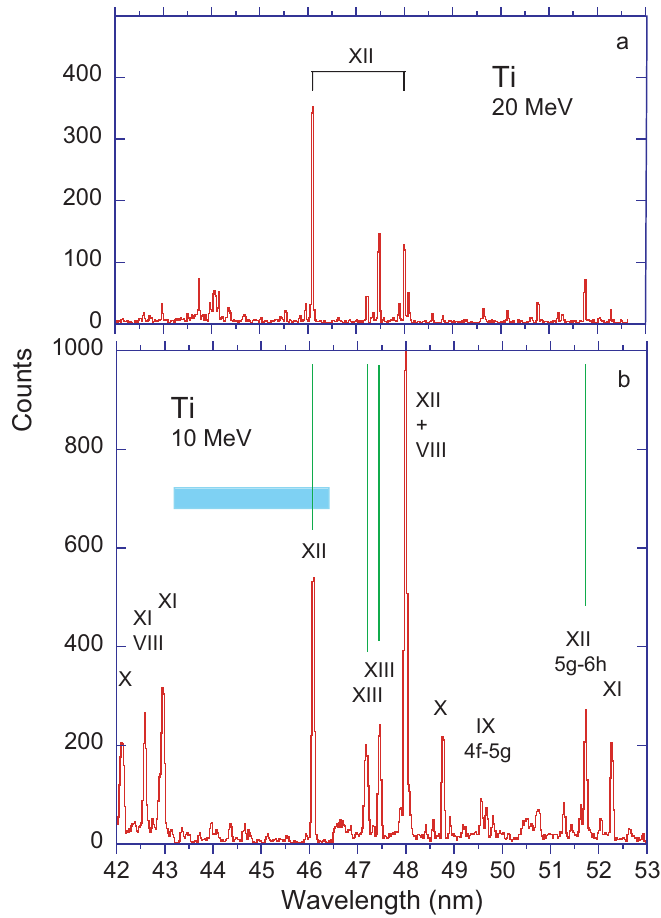
Figure 7. Continuation of the Ti spectra shown in Figures 4–6. ( a ) ion beam energy 20 MeV, ( b ) ion beam energy 10 MeV.